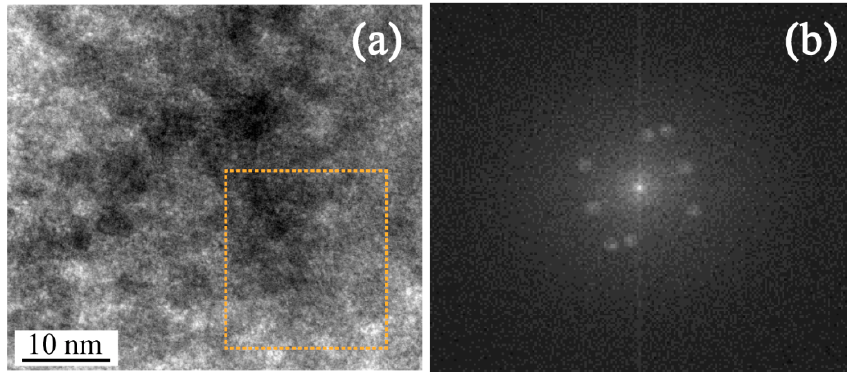
Figure 2. TEM and diffraction patterns of CMC/Eu nanoparticles. ( a ) TEM micrograph; ( b ) the selected area electron diffraction (SAED) pattern.